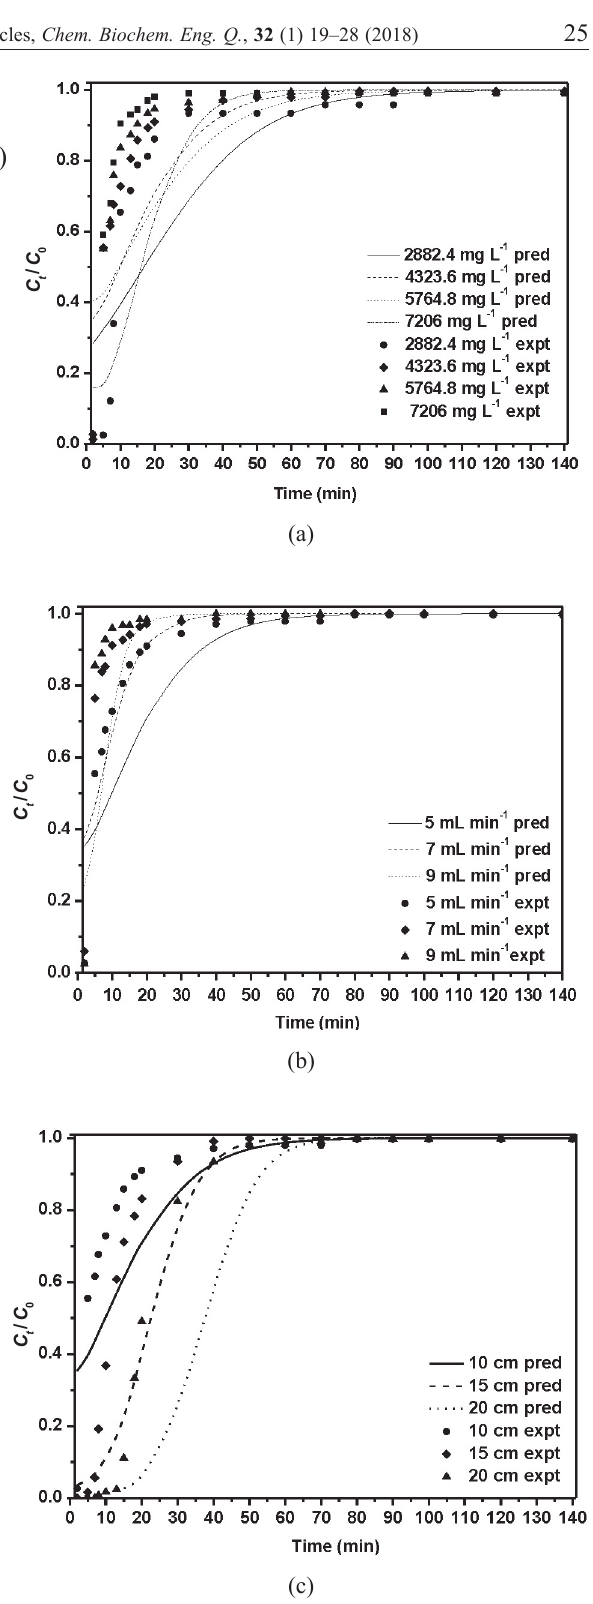
Fig. 6 – Comparison of experimental and predicted break- through curves using Thomas model at different (a) influent concentrations, (b) flow rates, and (c) bed